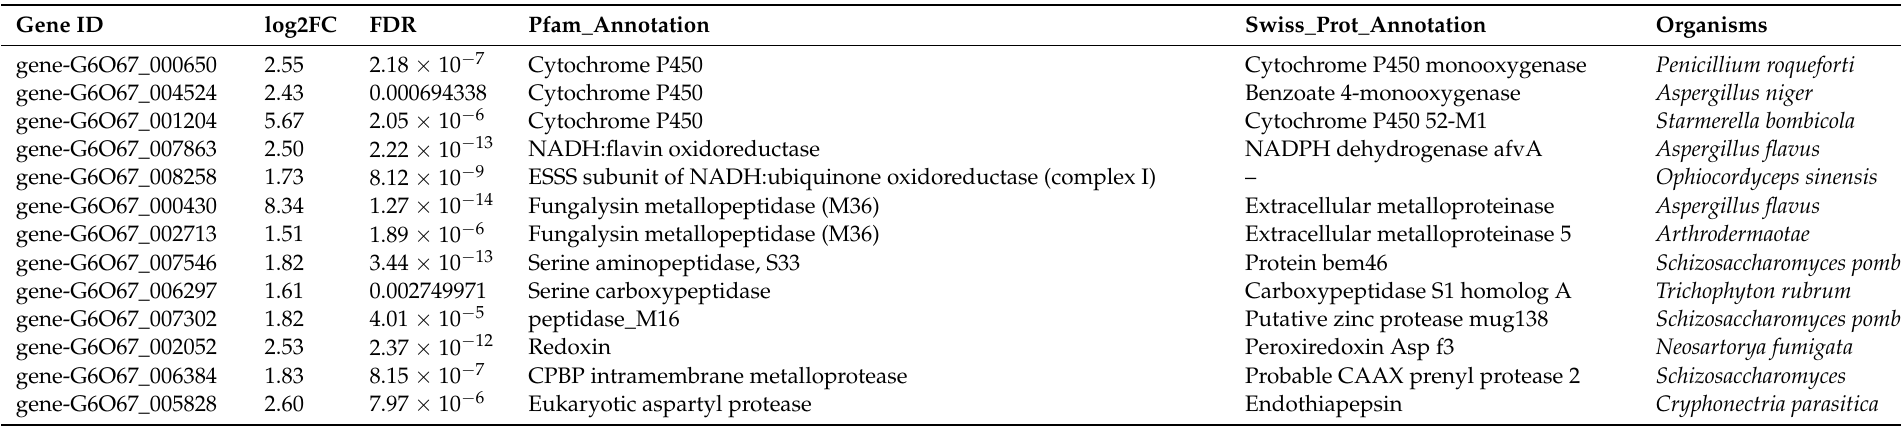
Table 1. The list of upregulated genes probably related to O. sinensis’s